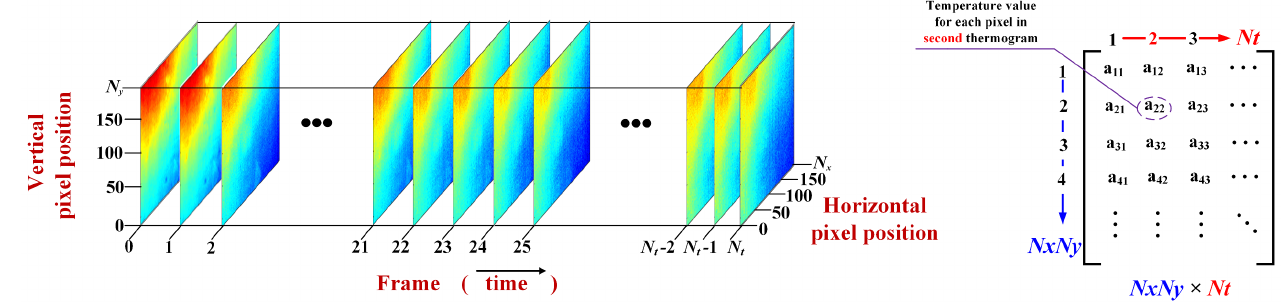
Figure 2. The 3D thermographic data sequence and 2D raster-like matrix.